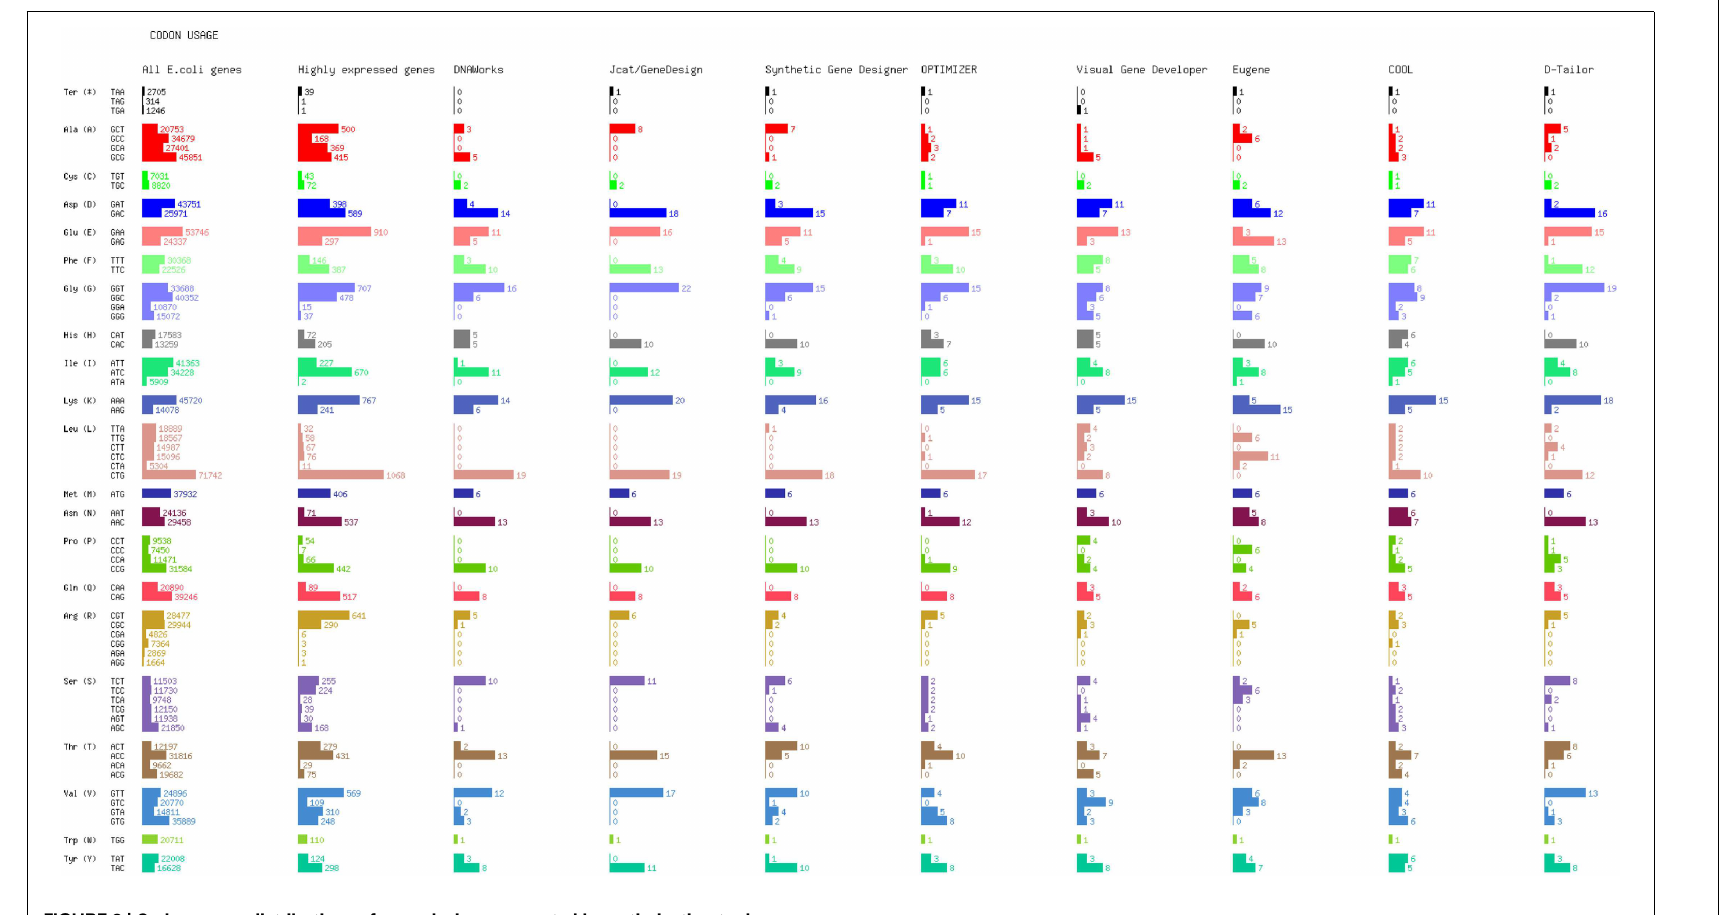
FIGURE 2 | Codon usage distributions of gene designs generated by optimization tools